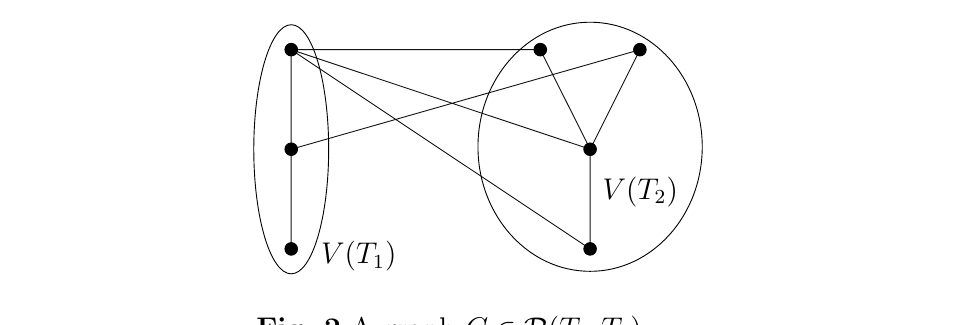
Fig. 2 A graph G ∈ P ( T 1 , T 2